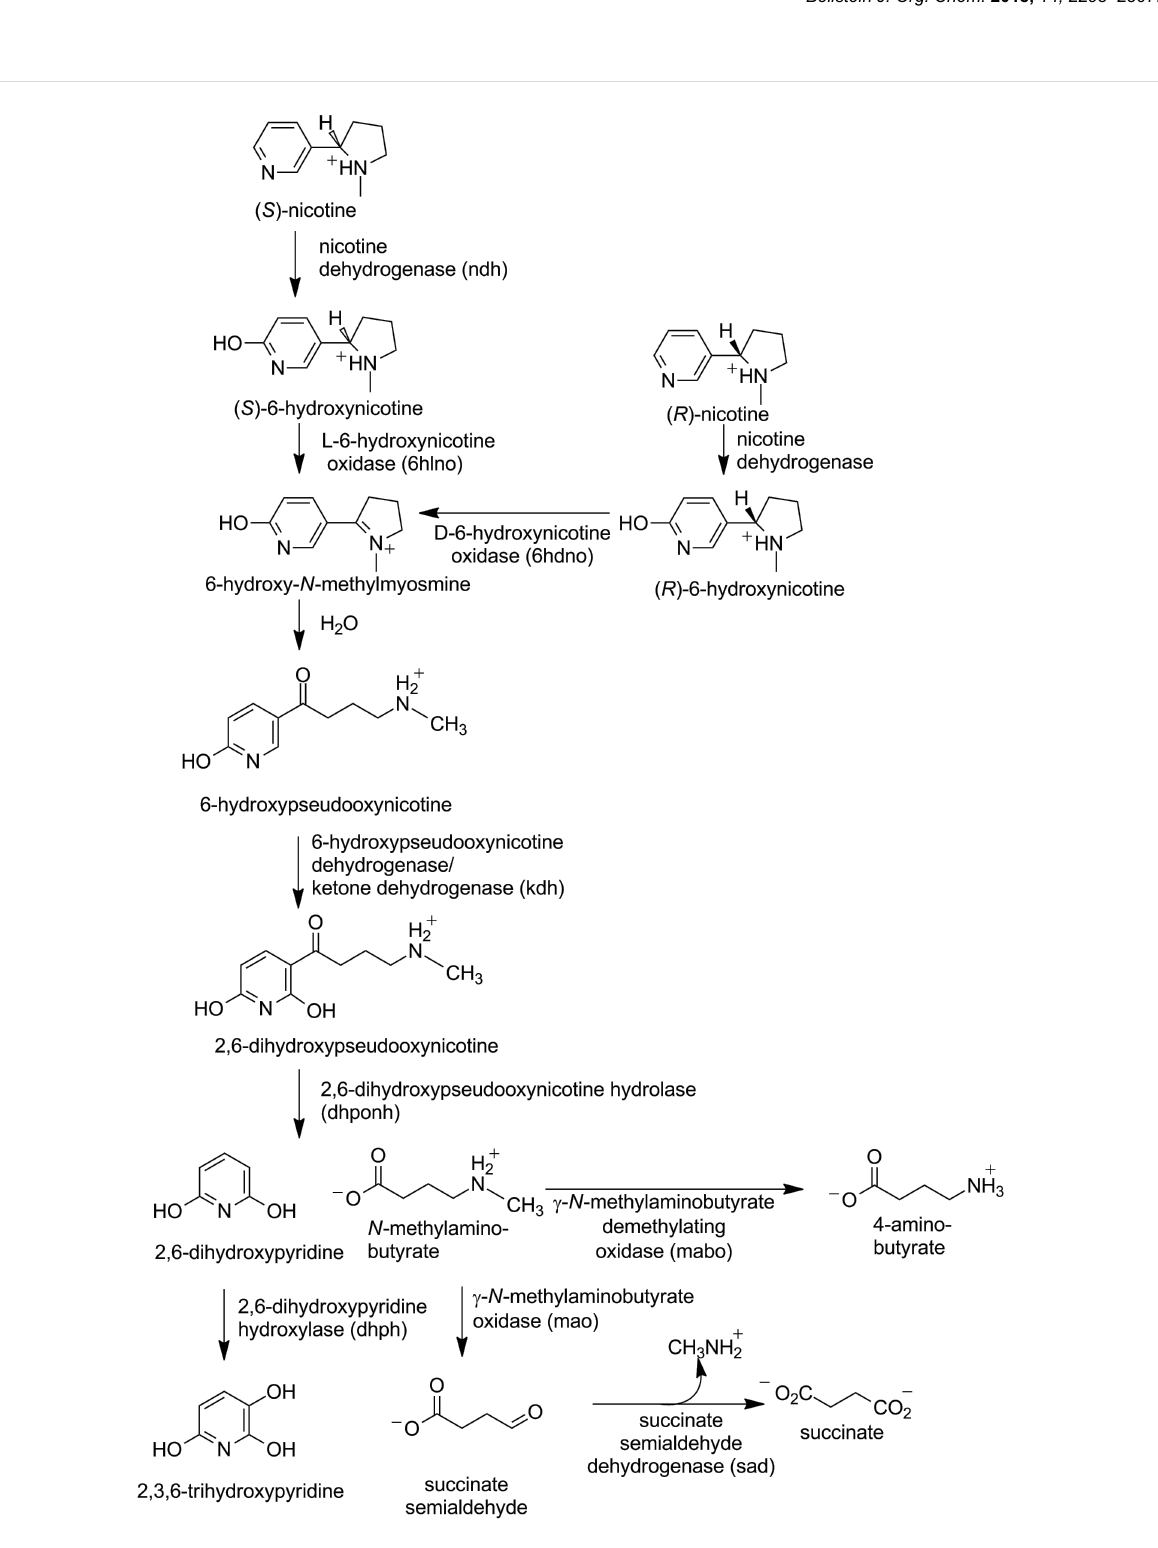
stopped-flow analyses of either the wild-type enzyme or the E352Q variant, ( R )-6-chloronicotine and ( R )-nicotine, which would not form the quinone methide, are still substrates, and